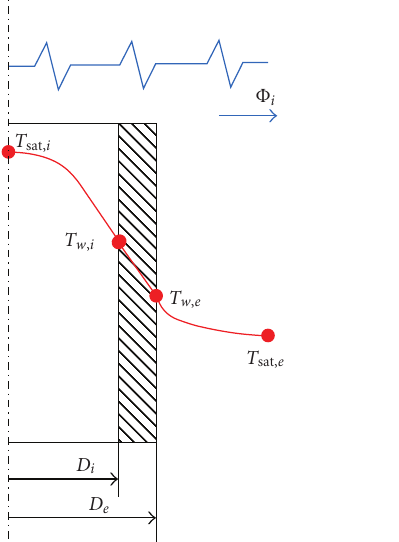
Figure 20: PERSEO facility experimental data compared with film condensation theory and Kim’s model [32] predictions.